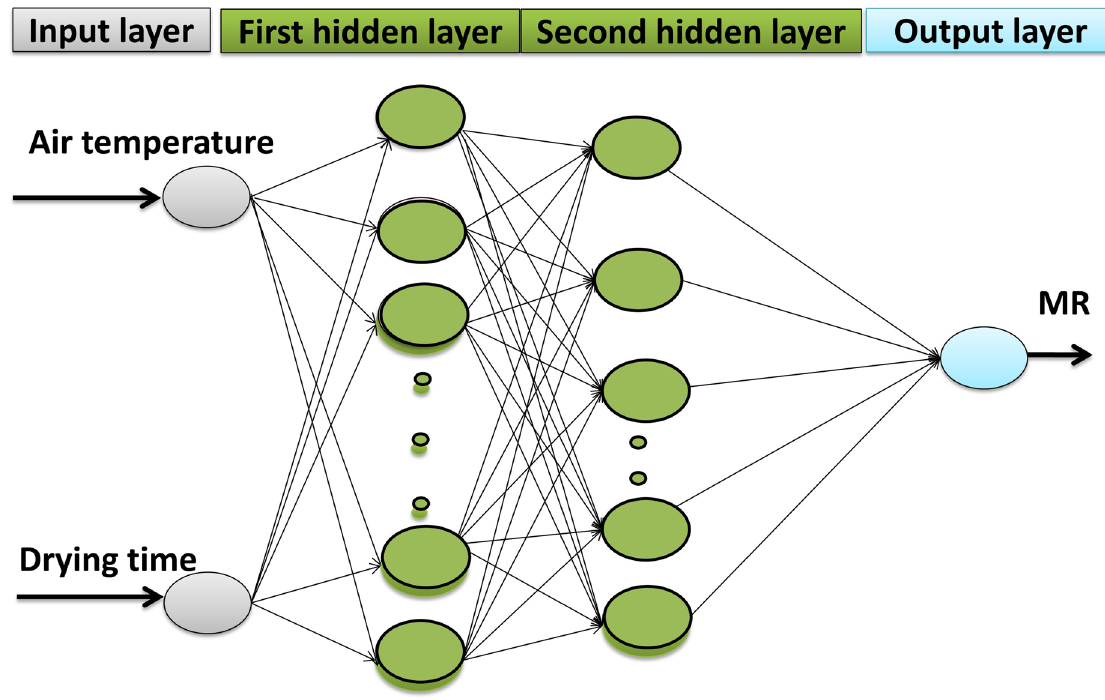
Figure 1. Four-layer ANN inputs and output structure used in this